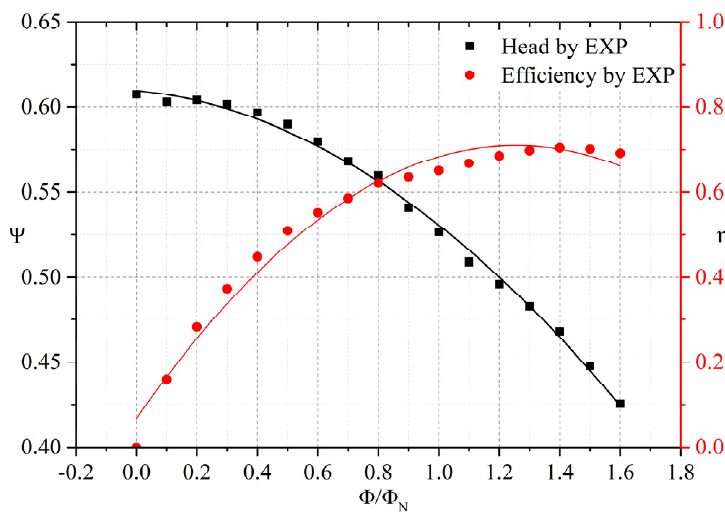
Figure 5. Performance of the model pump.